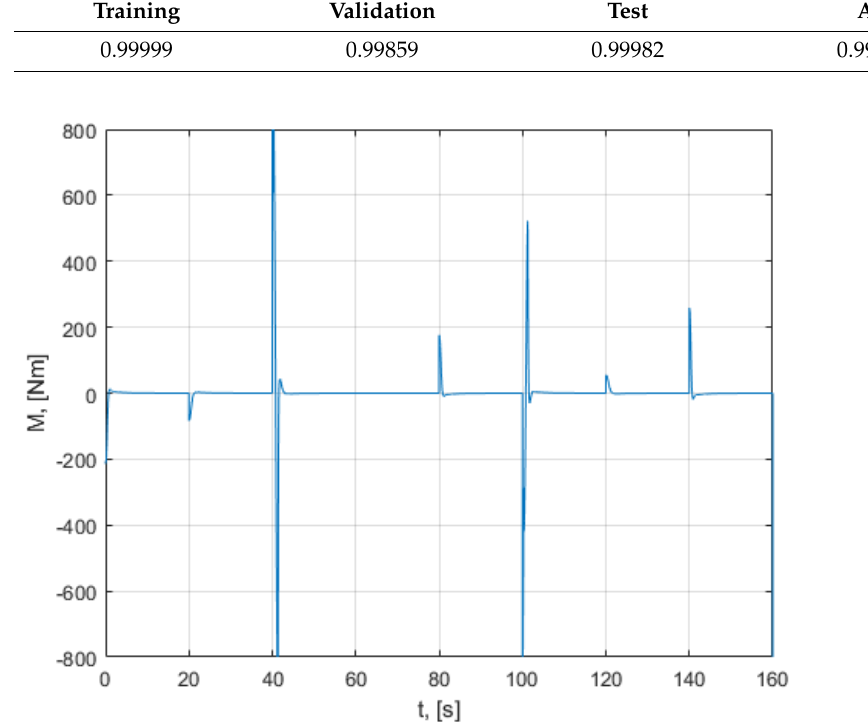
Figure 30. Speed characteristic.